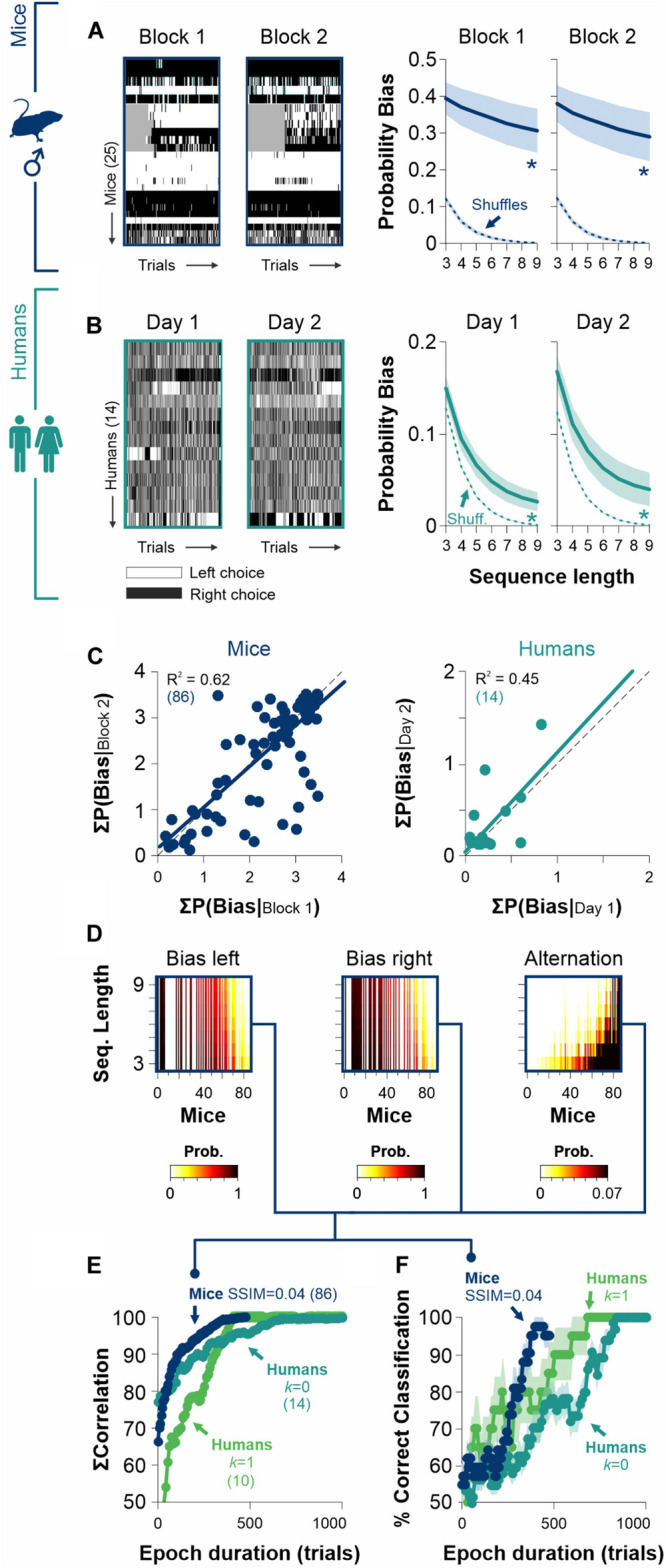
The stability of biased and alternating side-choice behavior serves to identify participants. (A) Side-choice colormaps (left) and side-choice probabilities for male mice (navy blue) measured in two different epochs with a gap of 146 days between them. (B) Side choices of humans (dark cyan) are also relatively stable across different days. Side-choice colormaps on the left. (C) Scatter plots of the area under the curve (AUC) for the bias probabilities obtained in pre. vs. post. epochs for mice (left panel) and humans (right panel). (D) Sample side-choice bias/alternating probabilities extracted from 500 trials of 86 male mice solving the 2AUC task with high discriminability (SSIM = 0.04). (E) Cumulative match characteristic curves as a function of epoch duration. We made comparisons with the summed correlations (left, right, and alternating probabilities) as a function of epoch duration. (F) The same bias/alternating probabilities extracted from epochs of different lengths can be used to identify the mice (navy blue) and human participants (parakeet green, zero discriminability: k = 1; dark cyan, high discriminability: k = 0) with increasing accuracies for longer epochs. Number of subjects in parentheses.